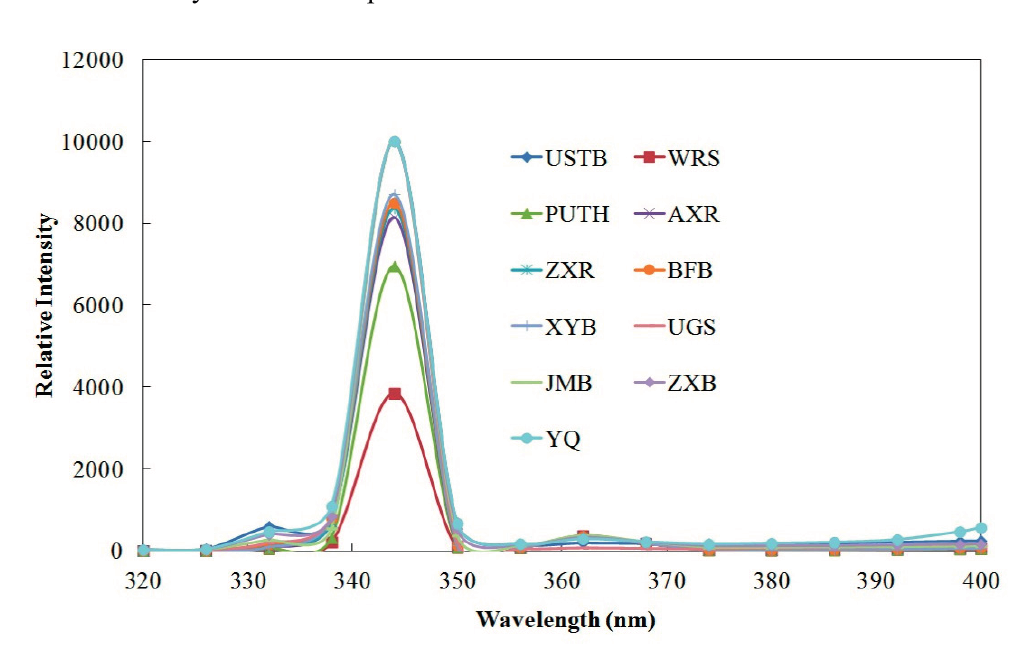
Figure 3. Result of fluorescence spectroscopy: higher relative intensity represents higher concentration of microbial